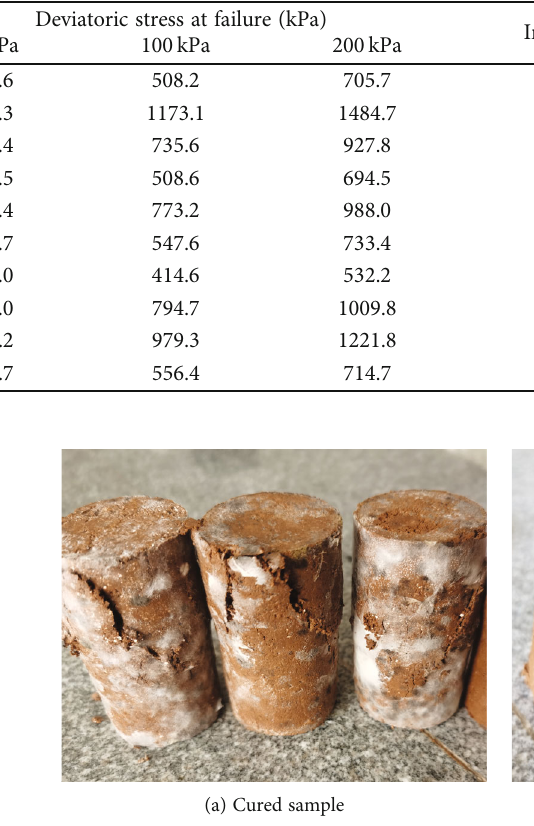
Figure 10: Comparison of samples after strength